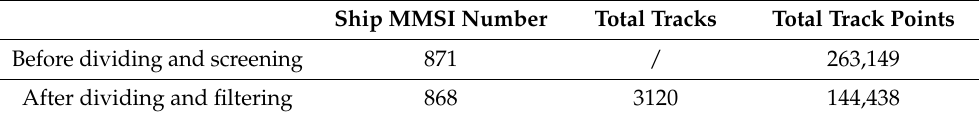
Table 2. Division and filtering